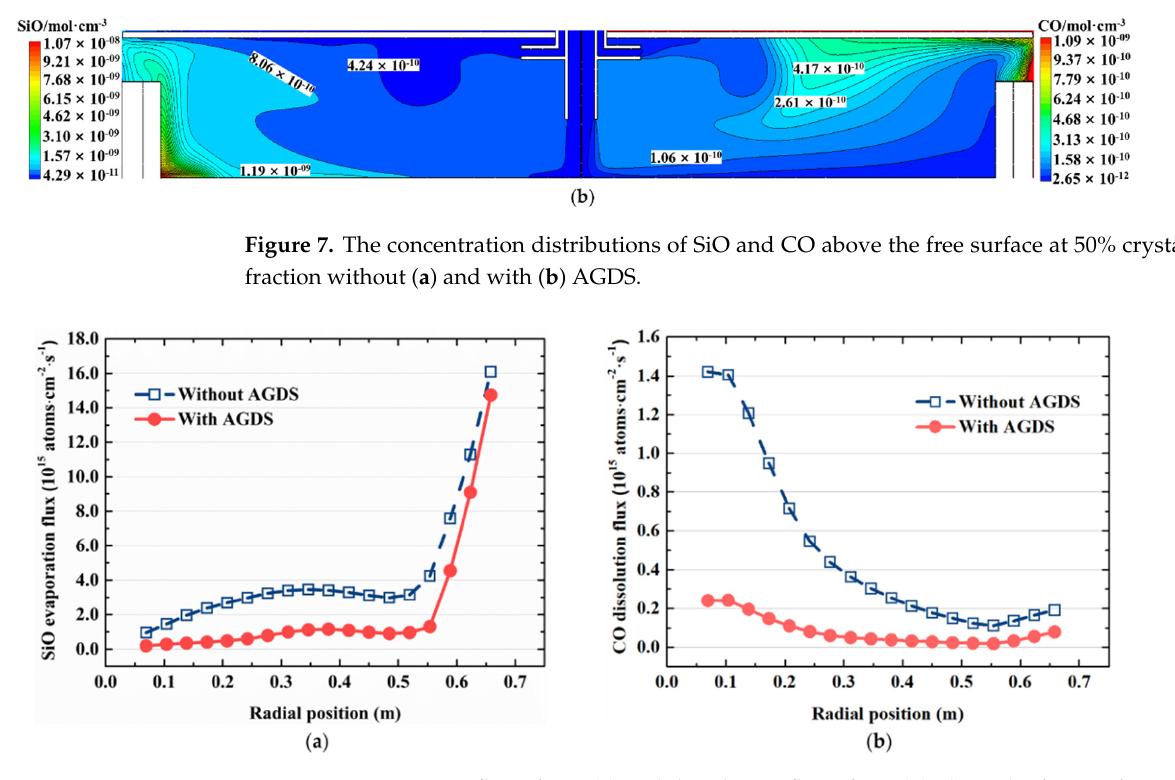
Figure 8. Evaporation flux of SiO ( a ) and dissolution flux of CO ( b ) along the free surface at 50% crystalline fraction.